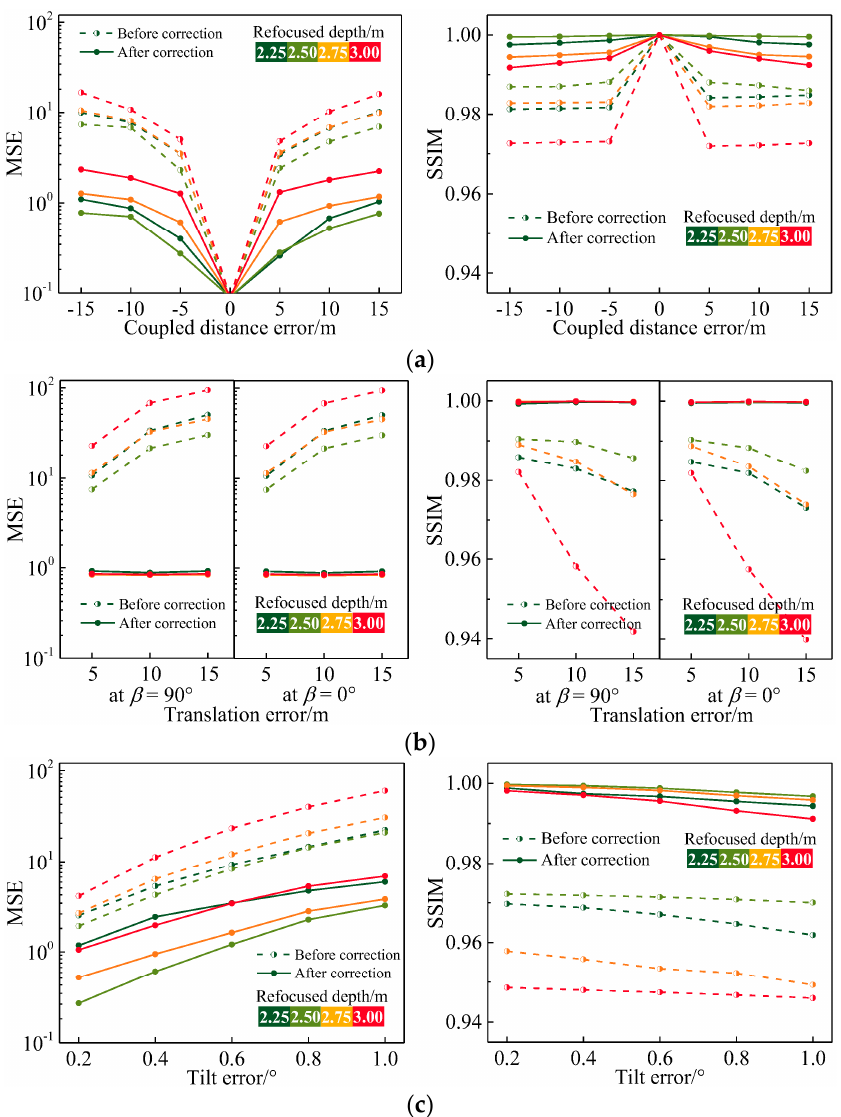
Figure 9. Correction results for light-field refocusing under different orientation error conditions: ( a ) Coupled distance error; ( b ) Translation error; ( c ) Tilt error.